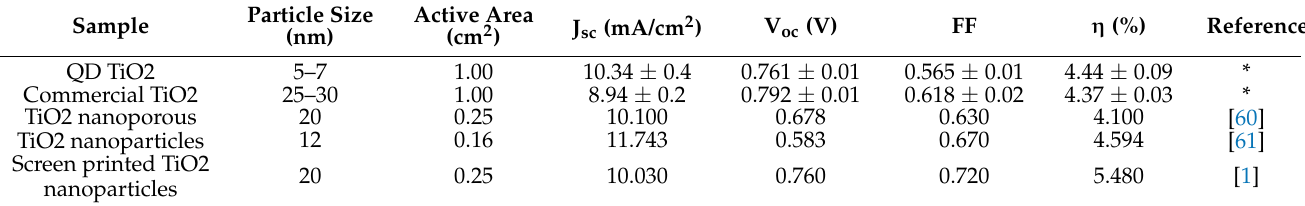
Figure 6. J–V curve of the QD TiO 2 and commercial TiO 2 nanoparticle-based DSCs. Table 1. Photovoltaic properties of the QD TiO 2 and commercial TiO 2 nanoparticle-based DSCs.